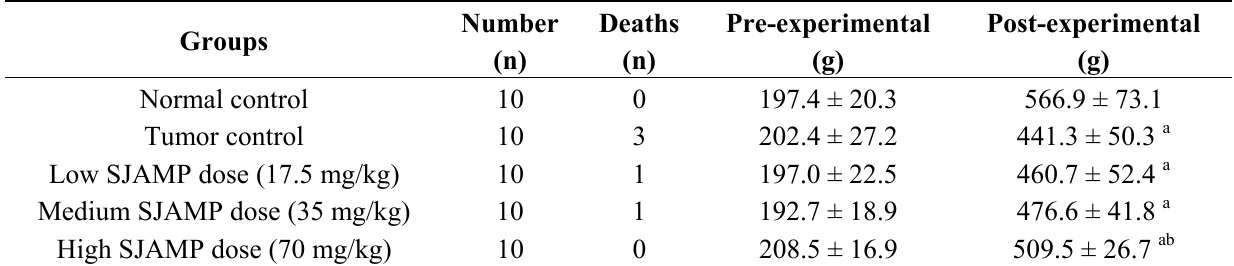
Table 1. Weight change of rats over the experimental period ( x ±